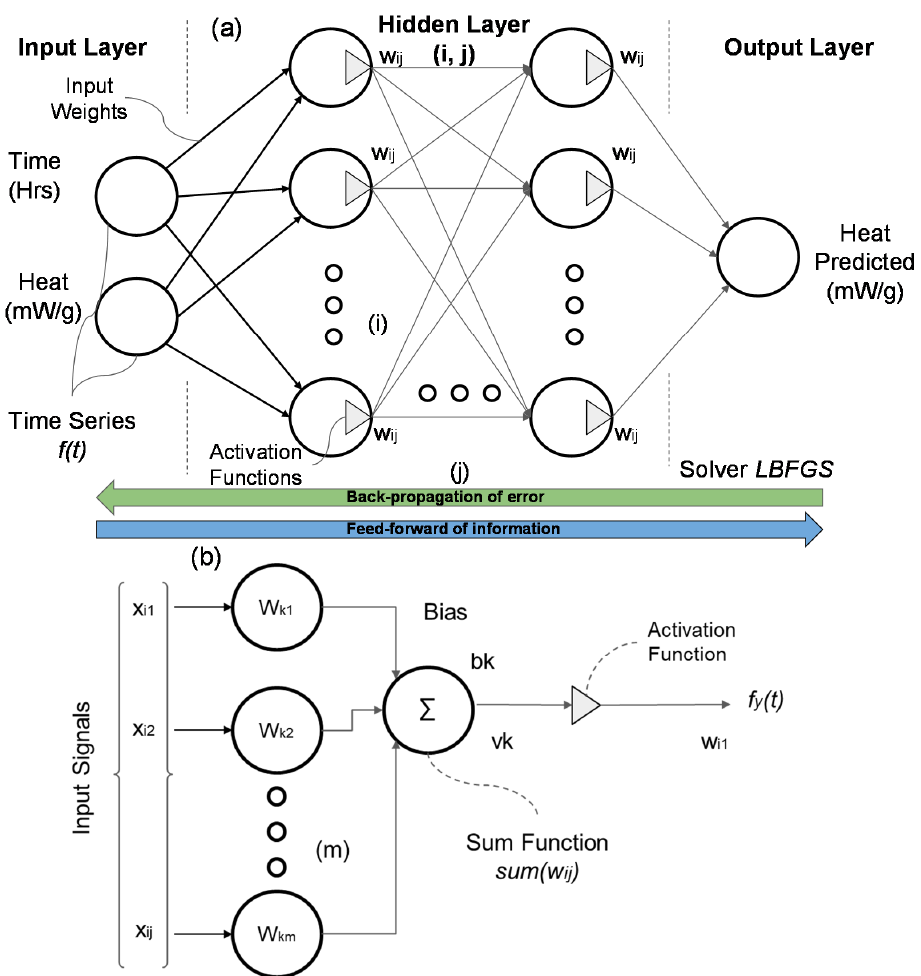
Figure 4. Simplified representation of an artificial neural network and its components: ( a ) Design Concept of a Multi-Layer Perceptron Model (MLP) and ( b ) Neuron simplified structure.